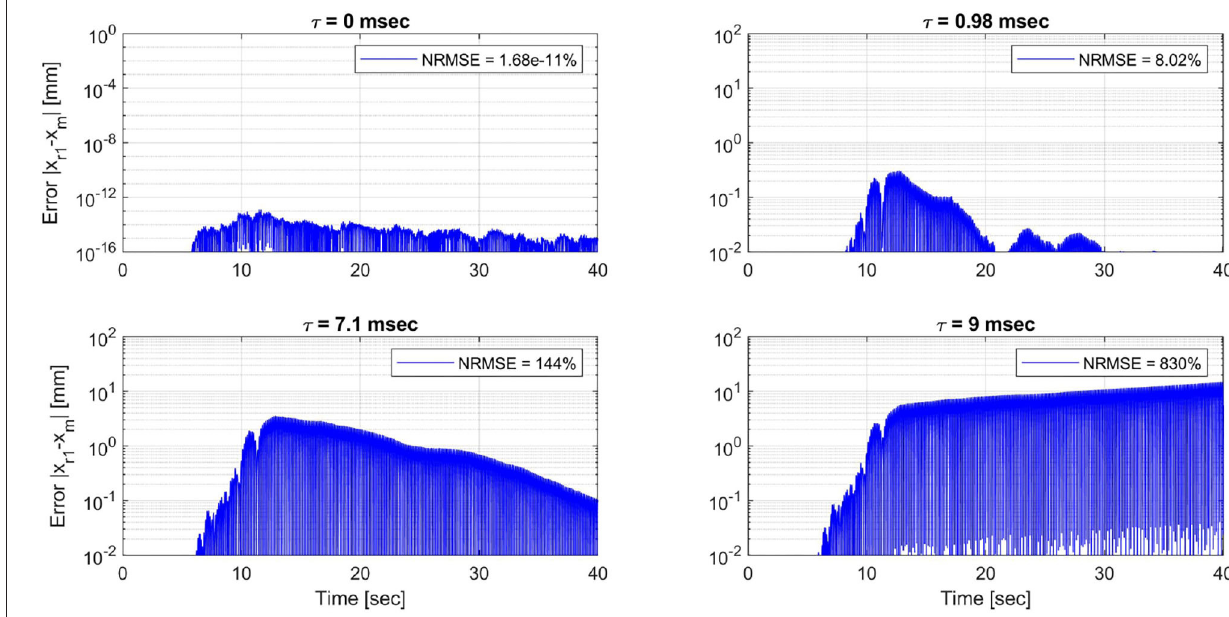
FIGURE 6 | Displacement error for different delay values.